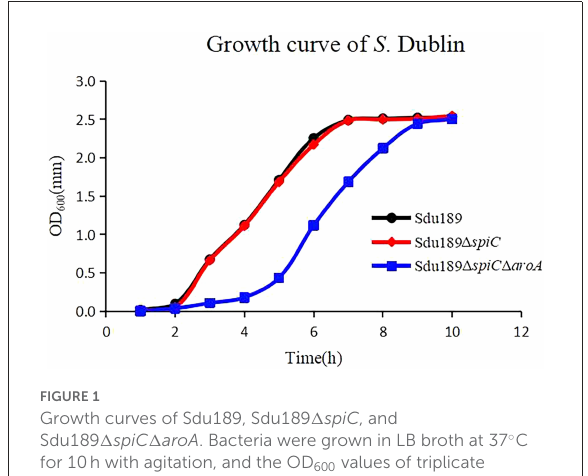
FIGURE1 Growth curves of Sdu189, Sdu189 1 spiC , and Sdu189 1 spiC 1 aroA . Bacteria were grown in LB broth at 37 ◦ C for 10h with agitation, and the OD 600 values of triplicate cultures in LB medium were determined in 1-h intervals.